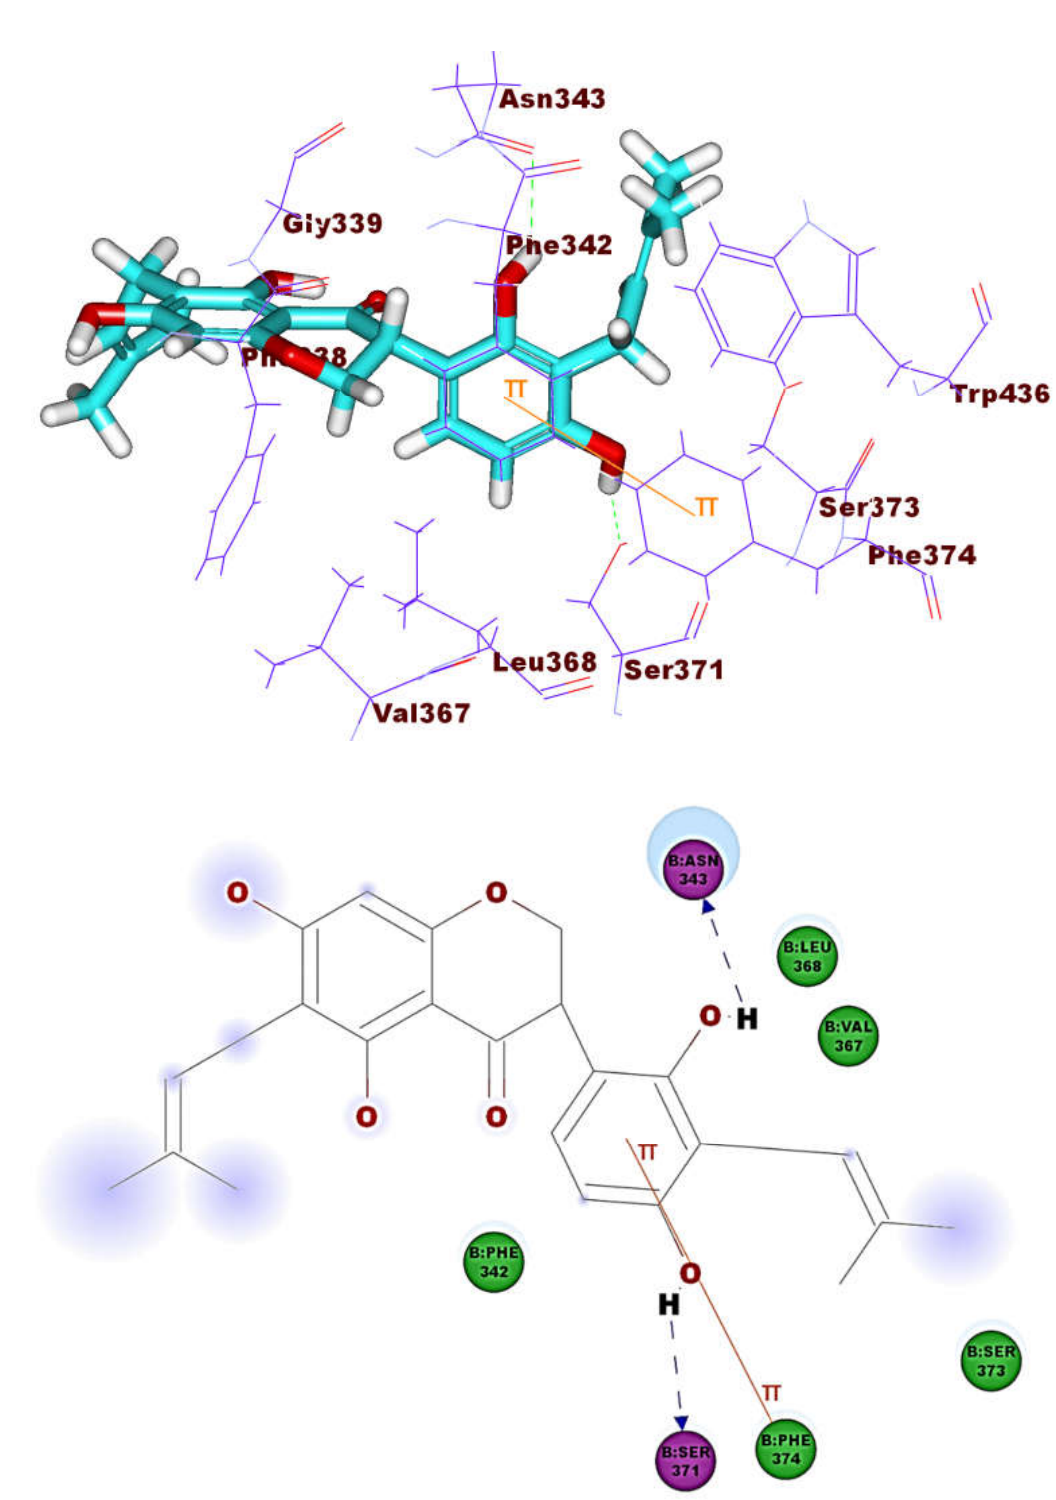
Figure 8. Compound 56 docked into ACE-2, forming two H. bonds with Ser371 and Cys336 .